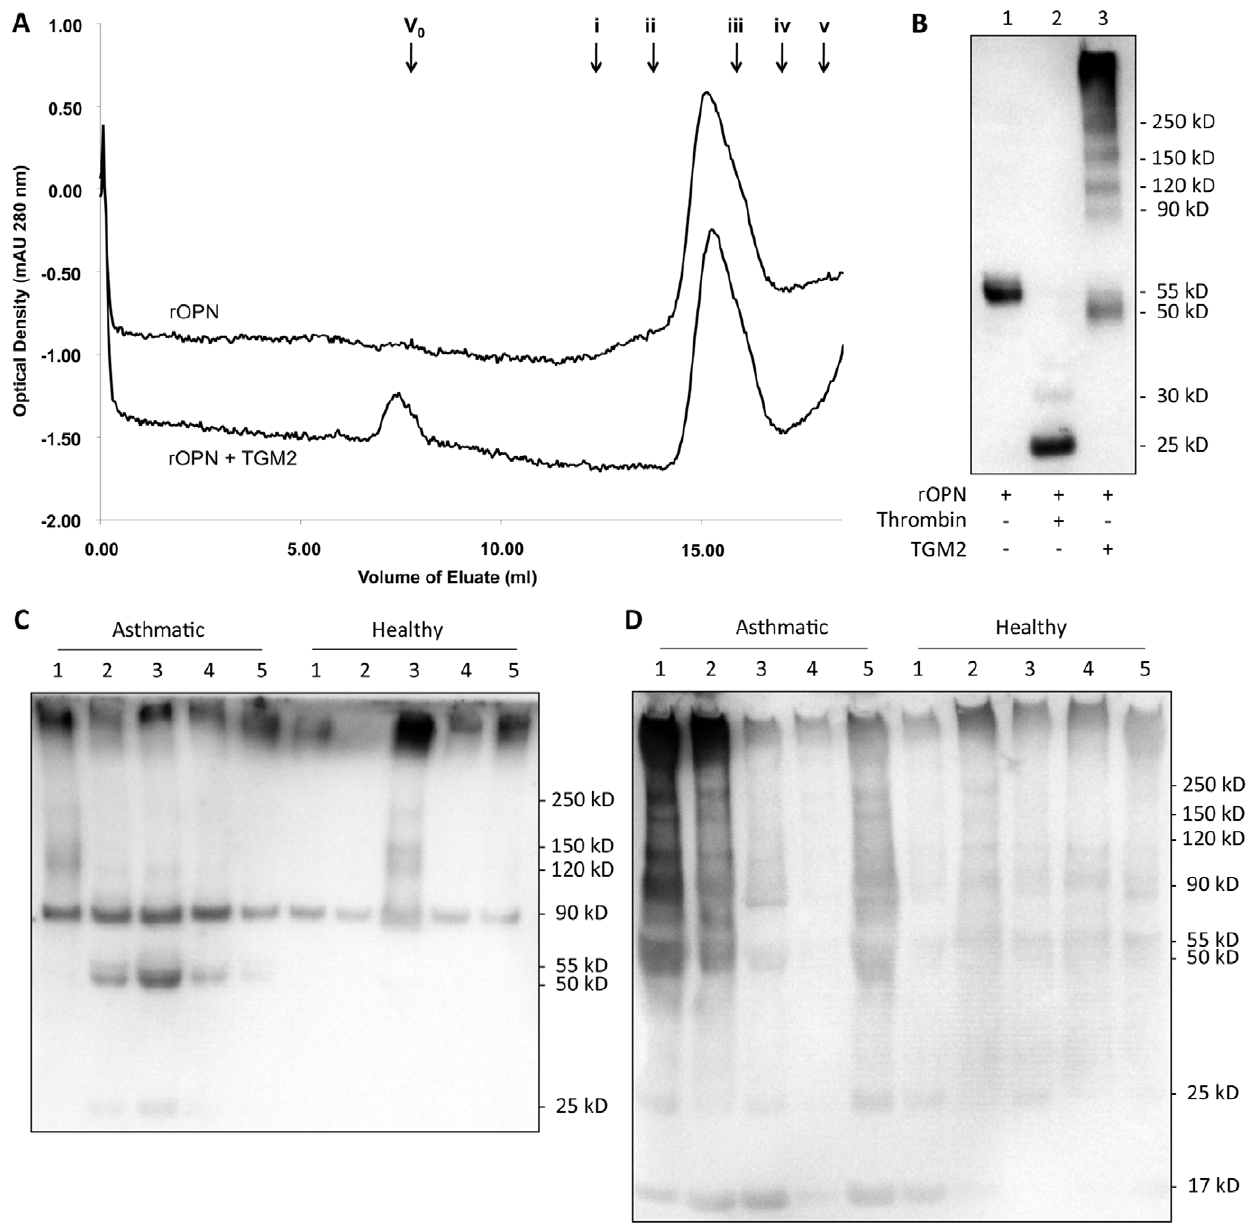
Figure 1. Monomeric, cleaved, and polymeric rOPN, BAL, and sputum sOPN. 1A- Size exclusion chromatogram of rOPN and TGM2-treated (polymerized) rOPN; V 0 : void volume; i: thyroglobulin (669 kD); ii: apoferritin (460 kD); iii: gamma globulin (158 kD); iv: bovine serum albumin (65.5 kD); v: human chymase (30 kD). 1B- Immunoblot of rOPN, thrombin-cleaved rOPN, and TGM2-treated (polymerized) rOPN. Lane 1: rOPN; Lane 2: rOPN treated with thrombin; Lane 3: polymeric rOPN made using TGM2. 1C- Immunoblot of BAL samples from 5 healthy and 5 asthmatic subjects probed with affinity purified polyclonal anti-human sOPN antibody. 1D- Immunoblot of induced sputum samples from 5 healthy and 5 asthmatic subjects probed with affinity purified polyclonal anti-human sOPN antibody. The polymeric sOPN bands that produced a continuous smear were measured as a single band. Other polymeric bands were measured separately. For the purpose of analysis, consistent with the described molecular weights of various forms of sOPN and with our polymerization and cleavage experiment, bands from 40 up to 90 kD were considered to be monomeric. Bands $ 90 kD were considered as polymeric (bands between 90 and 100 kD were considered dimeric sOPN) and bands , 40 kD were considered to be cleaved.